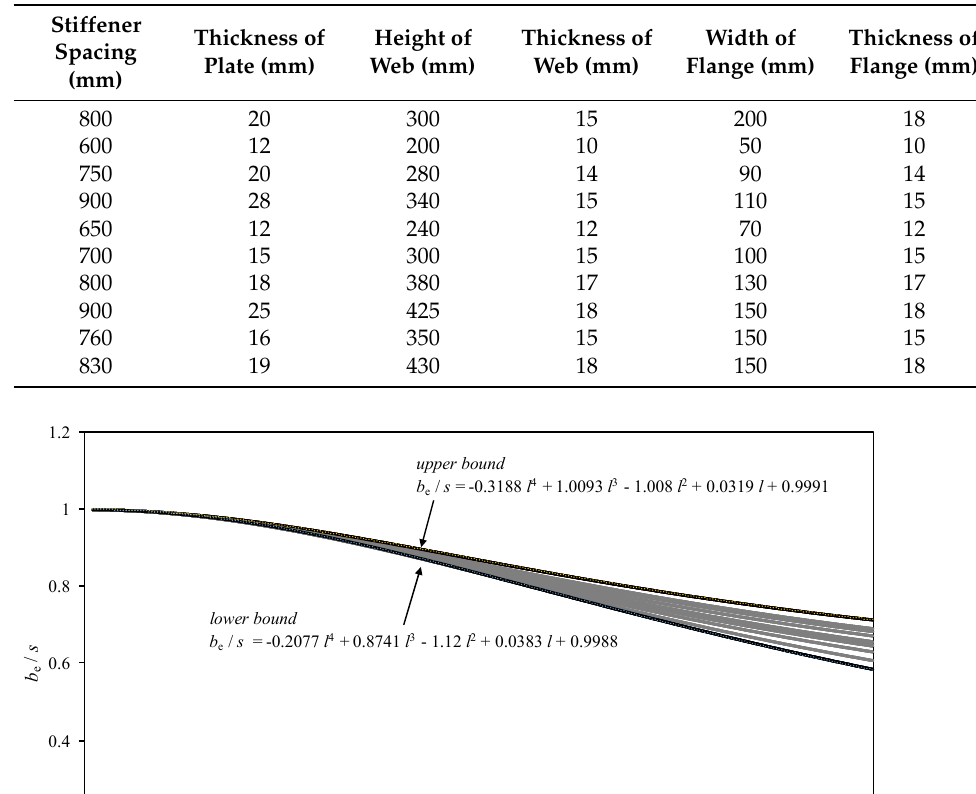
Table 1. Dimensions of “Tee” profile stiffened panels.